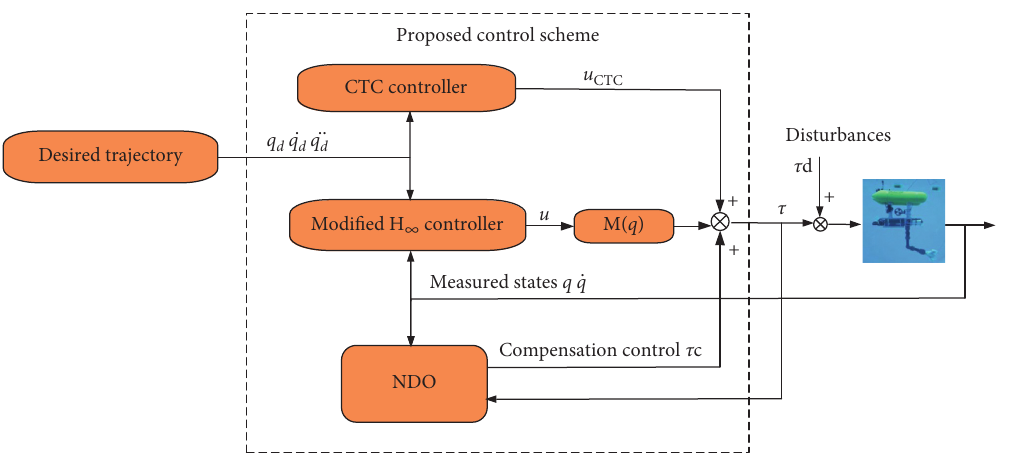
Figure 5: The control system structure of the proposed online robust control scheme. Table 1: Mass and buoyancy used in the UVMS.